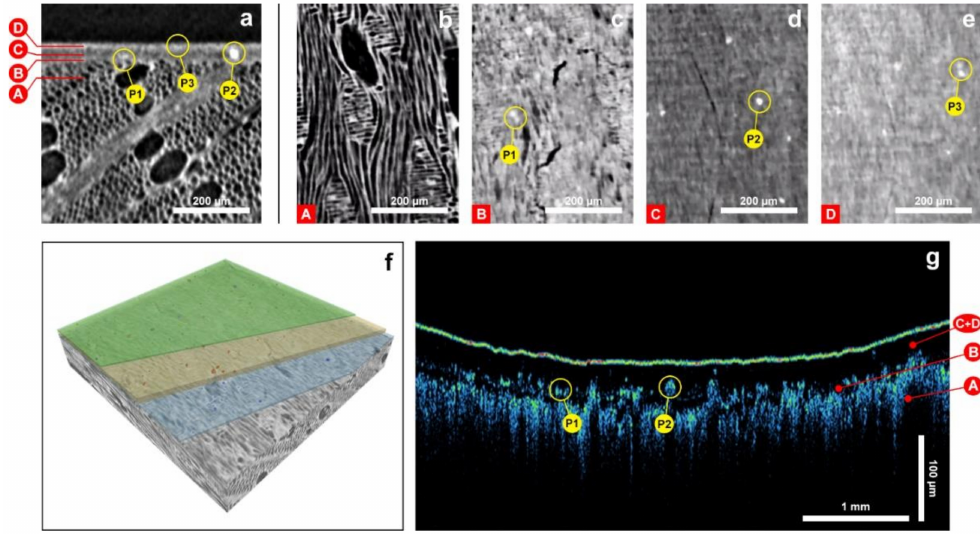
Figure 3. Fragment F01, Jacobus Stainer. ( a ) Transverse slice from the SR-micro-CT volume with the identified layers; different layers are highlighted in capital letters and different particles are indicated as P1, P2, and P3. ( b – e ) Radial slices from the SR-micro-CT volume showing the finishing layers discussed in the text and reporting the particles P1, P2, and P3 indicated in ( a ) and identified at different depth. ( f ) Virtual reconstruction based on SR-micro-CT volume. The preparation layer (B in Figure 3a) is colored in blue with dark blue particles; the varnish layer C is shown in yellow with particles colored in red and the outermost layer D is green with violet particles. ( g ) The OCT tomogram presented in false-color scale (see Section 2.2 for details). The wood substrate A, the preparation layer B, and the varnish layer C + D are shown. Particles embedded in the preparation layer and in the varnish are indicated as P1 and P2,